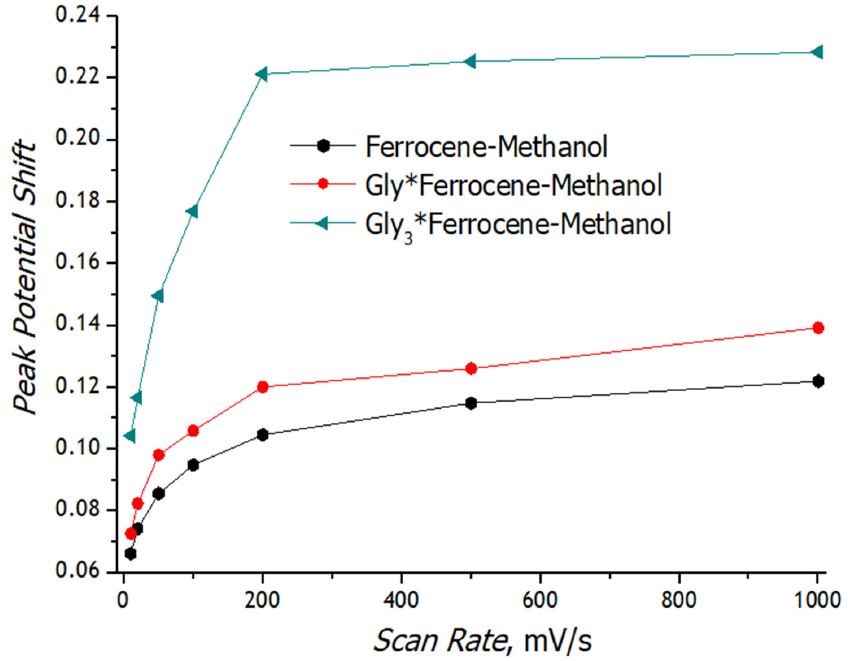
Figure 17. Peak potential shift as a function of sweep rate for ferrocenemethanol and its esters with glycine and triglycine.